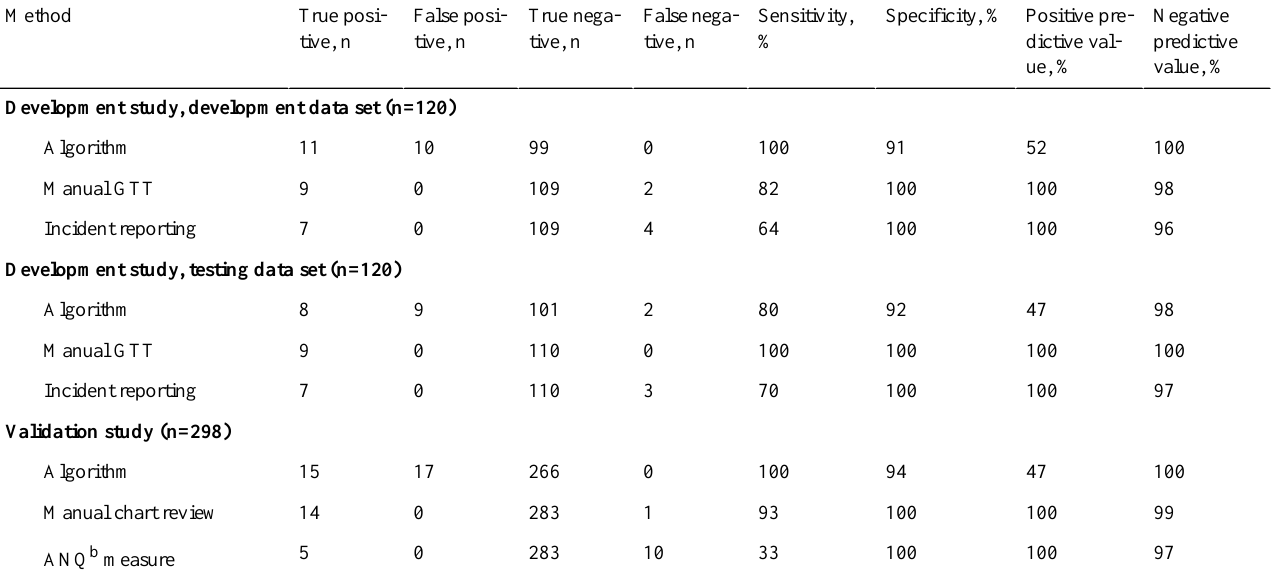
Table 2. Diagnostic accuracy results of the comparison between algorithm and all other detection methods in the development and validation